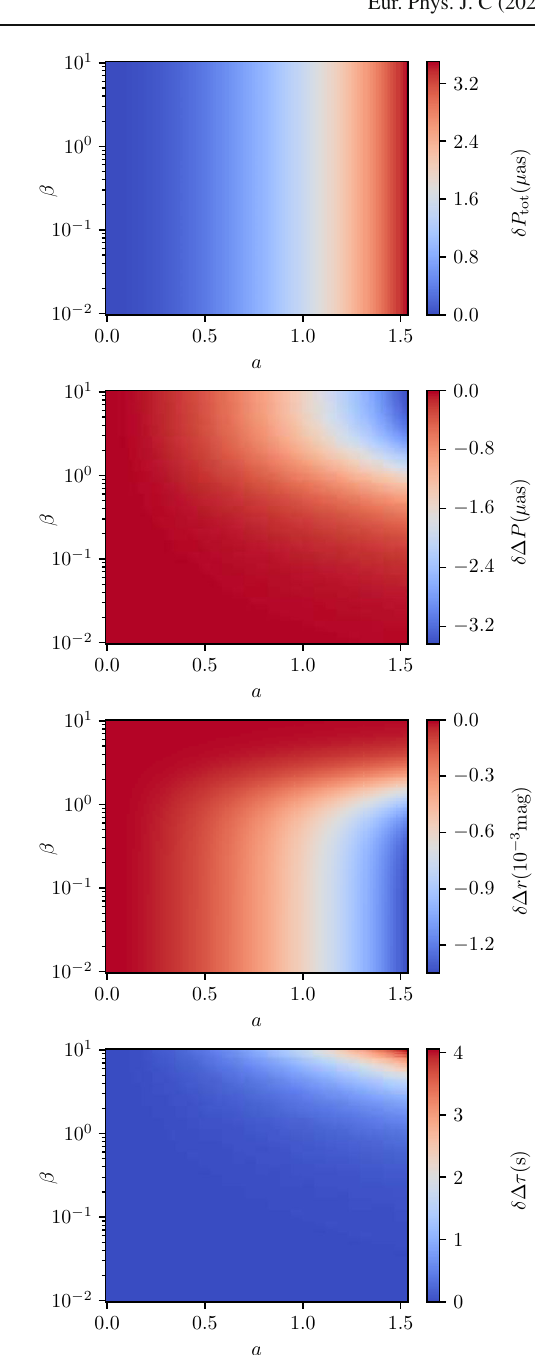
mation a for Sgr A*. From top to bottom, the left panel demonstrates P tot , (cid:15) P , (cid:15) F and (cid:15)τ ; and the right panel displays δ P tot , δ(cid:15) P , δ(cid:15) r and δ(cid:15)τ